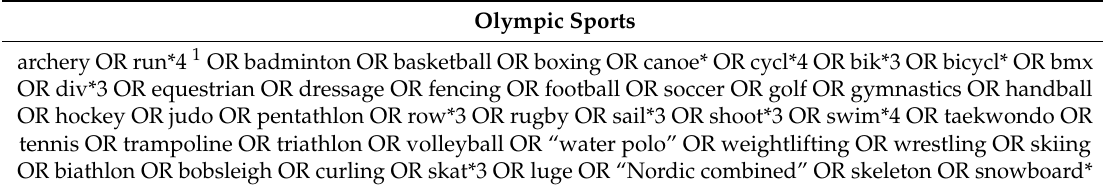
Table 2. List of Olympic